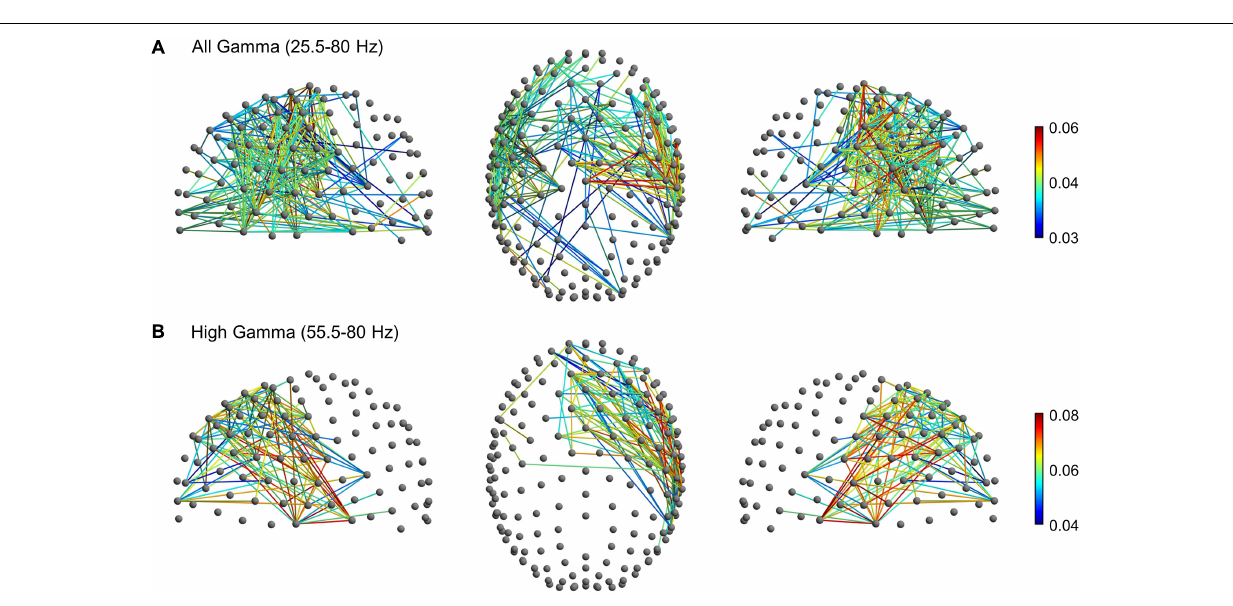
FIGURE 6 | Significant subnetwork with increased connectivity in the post-movement window compared to the planning phase ( p < 0.001, corrected for multiple comparisons) in the (A) broad gamma (25.5–80 Hz) and (B) high gamma (55.5–80 Hz) frequency bands. The nodes and the links are depicted in two different projections (sagittal, on the left and right side; axial, in the center). Colormap indicates the difference of the mean wPLI values between the post-movement and planning